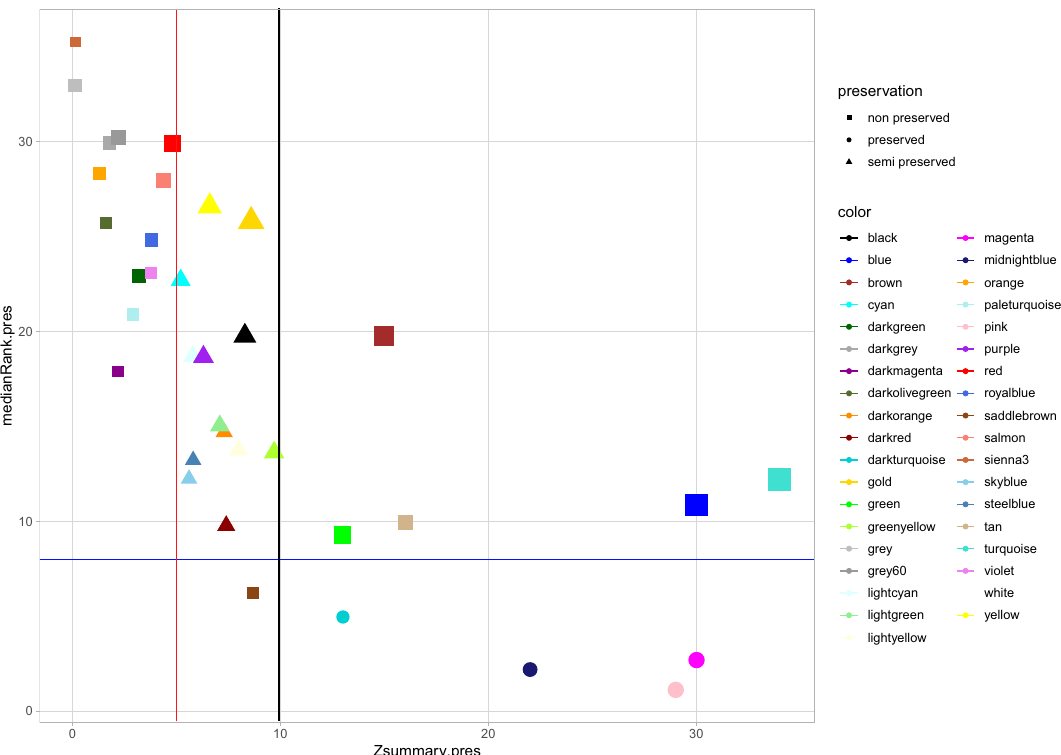
Figure 4. The medianRank (y axis) and Zsummary (x axis) statistics of the module preservation across 20 RNA-Seq datasets. Non-preserved, semi-preserved and preserved modules are indicated by square, circle and triangle points respectively in Rb-modules. The red and black vertical lines indicate the thresholds Zsummary = 8 and Zsummary = 10 respectively. The blue horizontal line indicates a threshold MedianRank = 8. The modules with Zsummary < 5 and MedianRank > 8 were considered as non-preserved, 5 < Zsummary < 10 and MedianRank > 8 semi-preserved and Zsummary > 10 and MedianRank < 8